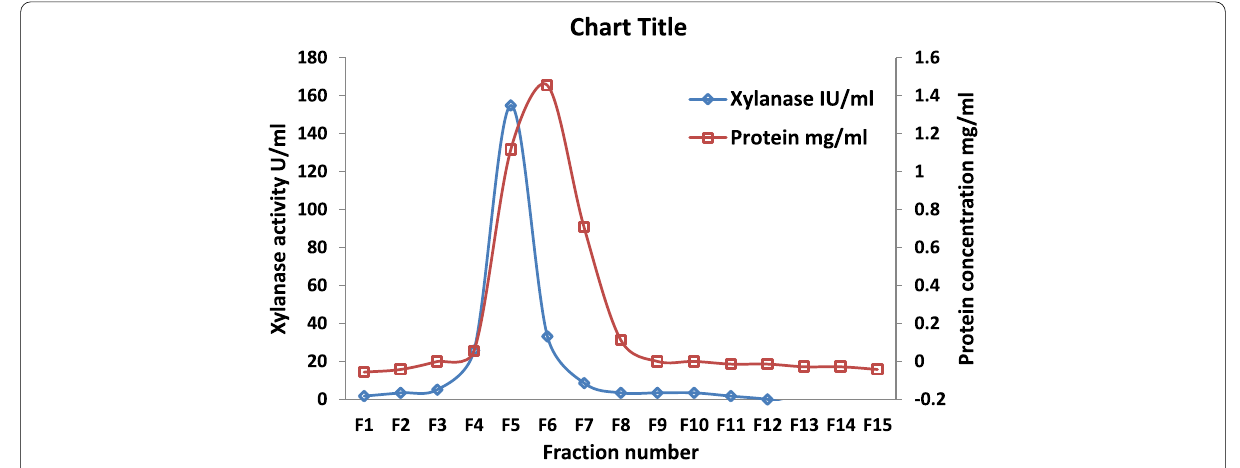
Fig. 2 Xylanase protein peaks in gel